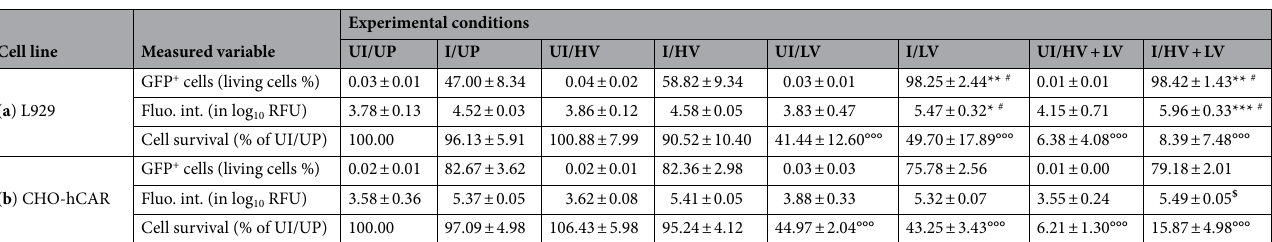
Cell survival (% of UI/UP) Table 1. Comparison of GFP gene expression and survival of L929 and CHO-hCAR cells following adenovirus infection and delivery of various types of electric pulse. ( a ) L929 and ( b ) CHO-hCAR were treated with the same procedures, except for the viral MOI (10 4 vp/cell and 50 vp/cell, respectively). GFP + cells (in % of living cells), median of fluorescence intensity (in log 10 RFU) and cell survival (in % of UI/UP cells) were scored by flow cytometry, 48 h after the treatment. UI uninfected, I infected, UP unpulsed, LV/HV/HV + LV application of low, high, high plus low voltage pulses, respectively, fluo. int . fluorescence intensity. Data are presented as means ± SD (with n = 6 for L929 and n = 3 for CHO-hCAR cells). Statistical significances: * p < 0.05, ** p < 0.01, and *** p < 0.001 stand for comparisons of GFP + cells and fluorescence intensity versus I/UP condition; # p < 0.05 and $ p < 0.05 for the same comparisons versus I/HV or I/LV condition (one-way ANOVA on ranks with Tukey post-test or one-way ANOVA with Bonferroni’s post-test for L929 and CHO-hCAR, respectively); °°° p < 0.001 for comparison of cell survival versus UI/UP condition (one-way ANOVA with Dunnett’s post-test).